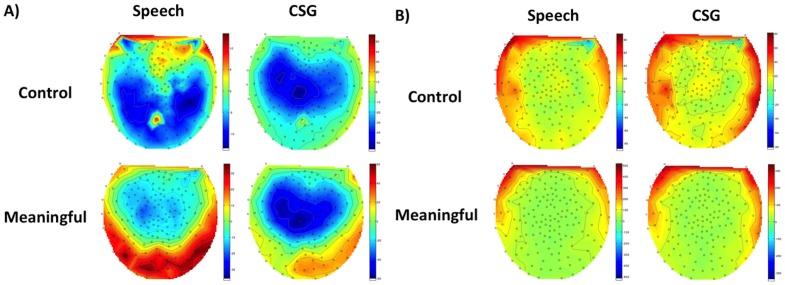
Topographical maps of the time-frequency responses for meaningful and control trials.Dashed lines show the average onset time of speech responses for the beta time-frequency window (15–25 Hz, 200 to 600 ms post speech onset) (A) and the high gamma time-frequency window (50–90 Hz, –100 to 100 ms post speech onset) (B).